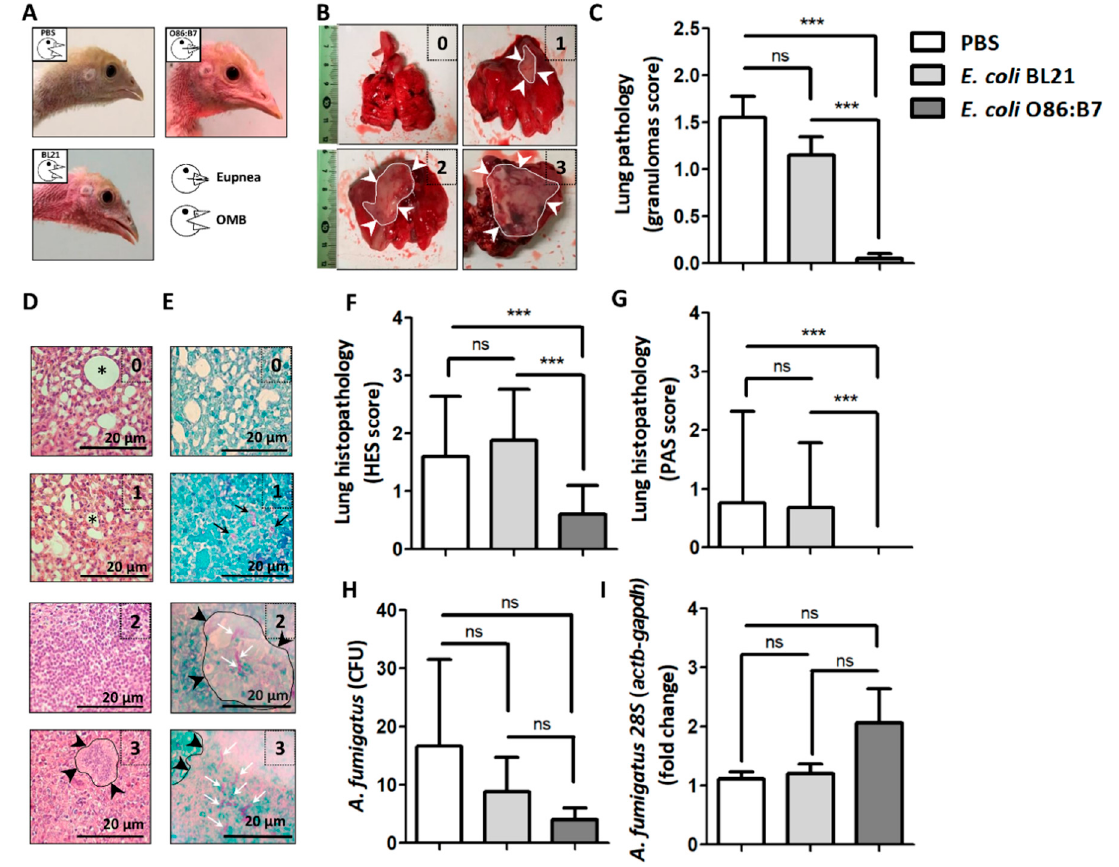
Figure 2. Oral administration of E. coli O86:B7 protects turkeys against aspergillosis. Clinical examination revealed that A. fumigatus infection produces open-mouthed breathing (OMB) in turkeys treated with PBS or E. coli BL21. Turkeys treated with E. coli O86:B7 were protected from developing OMB ( A ). Pulmonary lesions (i.e., granulomas, delimited area and white arrow heads) were scored (see methods). Examples of lungs with scores 0 to 3 are shown ( B ). Granuloma score was lower in turkeys treated with E. coli O86:B7 ( C ). Lung samples were processed for histopathology and stained with hematoxylin-eosin-saffron (HES, D ) and periodic acid-schiff (PAS, E ). Histological lesions were scored (see methods). Examples of histopathology samples with scores 0 to 3 are shown. Visible peribronchial regions (asterisk) and granulomas (delimited area and black arrow heads) are shown (HES score, D ). The presence of fungal germ-tube/hyphae (black arrows) and mycelium (white arrows) was scored (see methods). Granulomas associated with fungal hyphae (delimited area and black arrow heads) are shown (PAS score, E ). HES and PAS scores were lower in turkeys treated with E. coli O86:B7 ( F , G ). The presence of viable Aspergillus in lungs was quantified by colony-forming unit (CFU) counting assay ( H ). Fungal DNA levels were measured by A. fumigatus -specific 28S qPCR normalizing against turkey actb and gapdh as host genes using the 2 −ΔΔ C t ratio method. Results are relative to 28S levels in the control group (i.e., PBS) ( I ). No significant change was observed in the amount of CFU and 28S fold change ( H , I ). Size of bars is indicated. 100X magnification. Results shown are means and standard deviation values. Results were compared by One-way ANOVA with Dunnett’s multiple comparison test applied for individual comparisons (*** p < 0.0001; ns: not significant, 2 experiments, n = 30). 3.3. Oral Administration of E. coli O86:B7 Decreases Anti- α -Gal IgA Production in the Lungs of A. fumigatus-Infected Turkeys Natural Abs have affinity for different α -Gal-related antigens, including Gal α 1-3Gal disaccharide and Gal α 1-3Gal β 1-4GlcNAc trisaccharide. Sera levels of immunoglobulin Y (IgY) and IgA against Gal α 1-3Gal and Gal α 1-3Gal β 1-4GlcNAc were measured by ELISA in sera from turkey